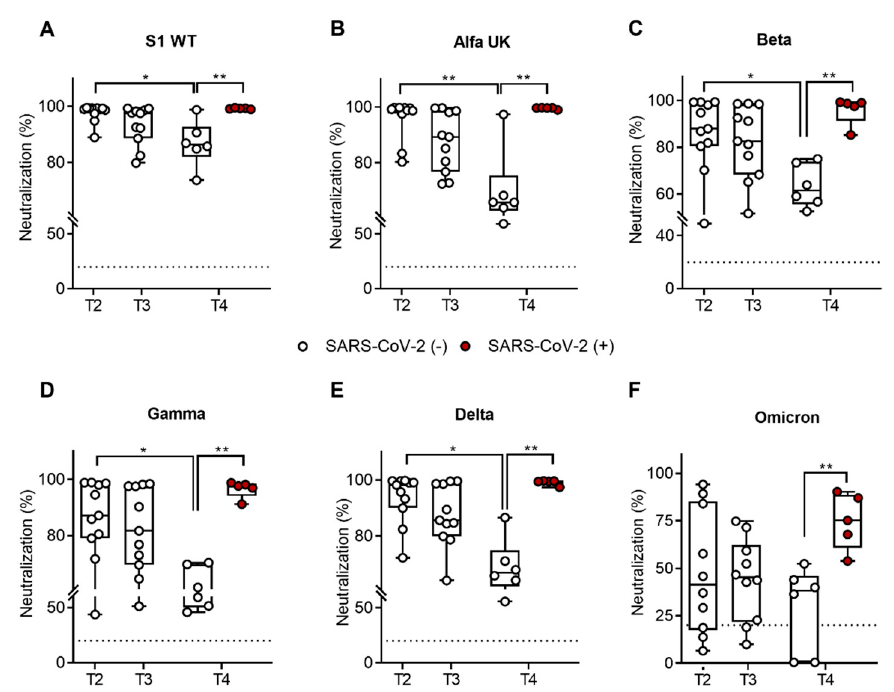
Figure 2. Percentage (%) of neutralizing activity to all SARS-CoV-2 VOCs in immunocompetent (ICs) healthy subjects (n = 11) after the Pfizer-BioNTech BNT162b2 mRNA-based vaccination. IgG neutralizing potential was evaluated three weeks (T2), as well as three (T3) and six months (T4), after the third booster dose. The time point T4 includes vaccinated subjects who contracted SARS- CoV-2 infection during the follow-up (n = 5), indicated as SARS-CoV-2 (+) (red dots), whereas uninfected subjects (n = 6) are indicated as SARS-CoV-2 ( − ) (white dots). The SARS-CoV-2-specific IgG neutralization ability against the SARS-CoV-2 wild type ( A ), alfa UK ( B ), beta ( C ), gamma ( D ), delta ( E ), and omicron ( F ). The dotted lines correspond to the cutoff level (>20%). The significance was determined using the Mann–Whitney test and t -tests; * p < 0.0332; ** p < 0.0021.